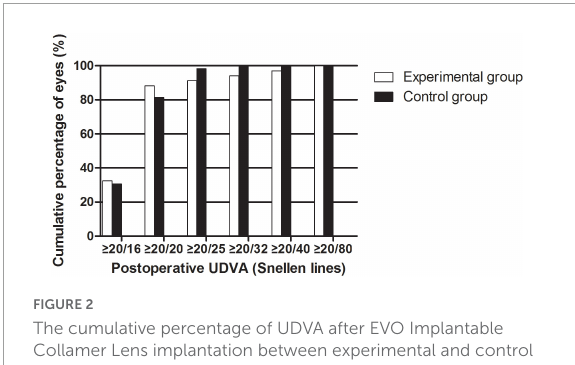
FIGURE2 The cumulative percentage of UDVA after EVO Implantable Collamer Lens implantation between experimental and control